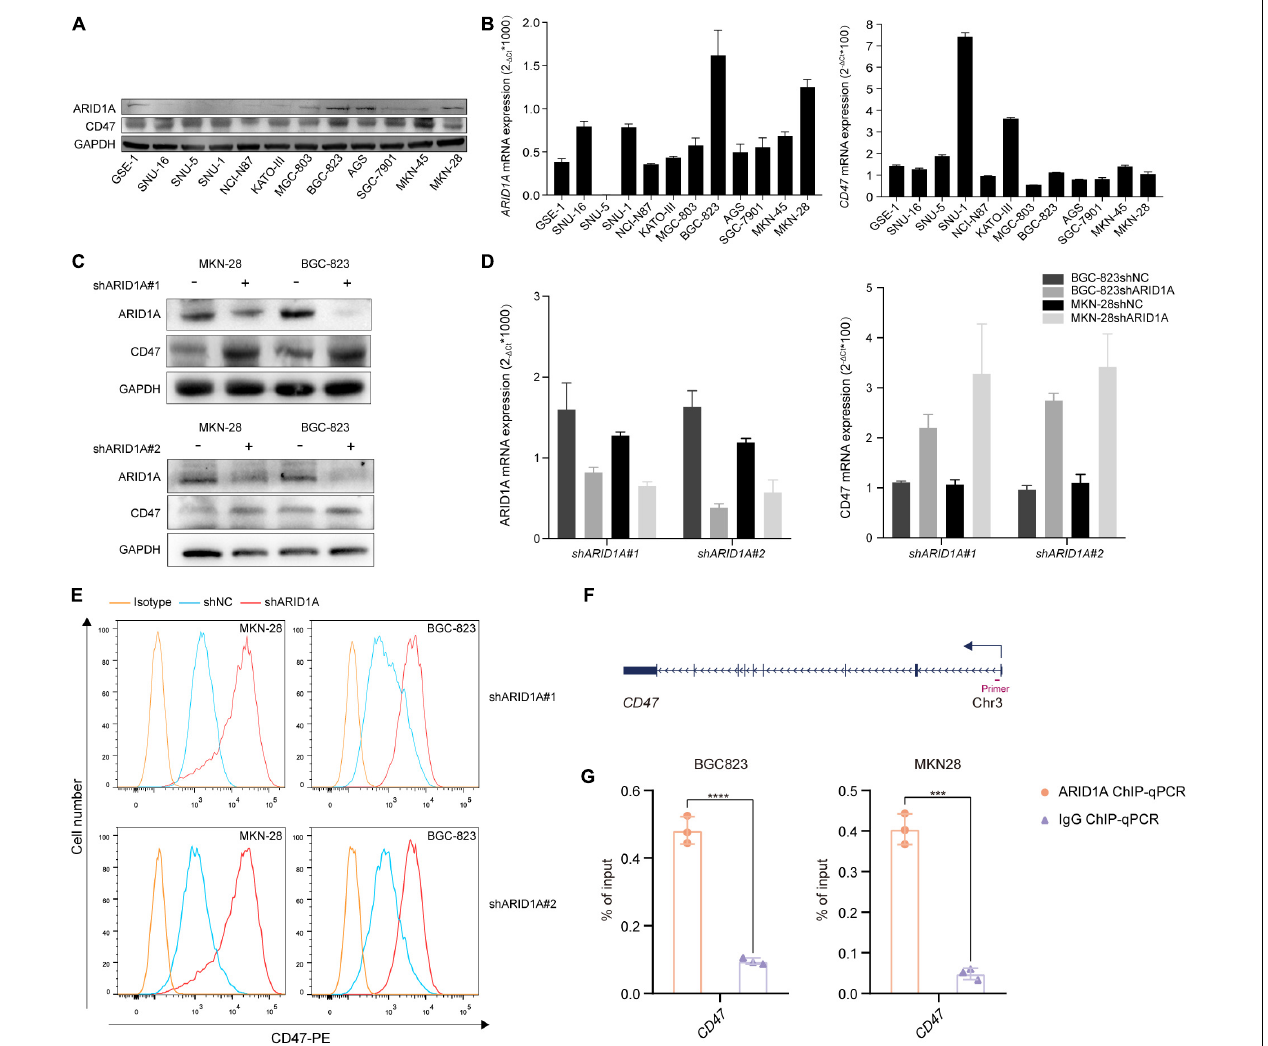
FIGURE 2 | Loss of ARID1A increases CD47 expression. (A,B) Protein and mRNA expression levels of ARID1A and CD47 among various GC cell lines. (C–E) Knockdown of ARID1A significantly increased total and membranous CD47 protein levels, and CD47 mRNA level measured by western blot, flow cytometry and qRT-PCR in GC cell lines. (F) Schematic illustration of the relative positions of qPCR probes to putative CD47 promoter region for ChIP-qPCR experiments. (G) ARID1A binding to the promoter region of CD47 was determined by ChIP-qPCR in BGC-823 and MKN28 cells, respectively. *** p < 0.001, **** p < 0.0001.